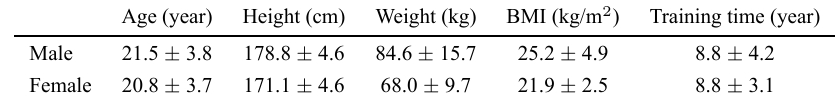
Table 1. Basic information of Chinese elite archers.